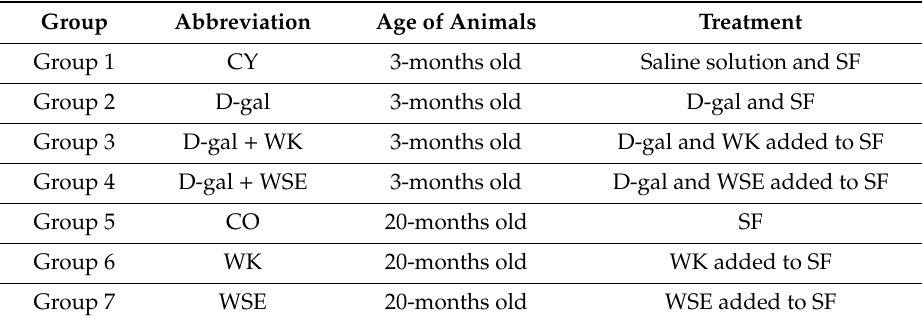
Table 1. Experimental groups and treatments used for each